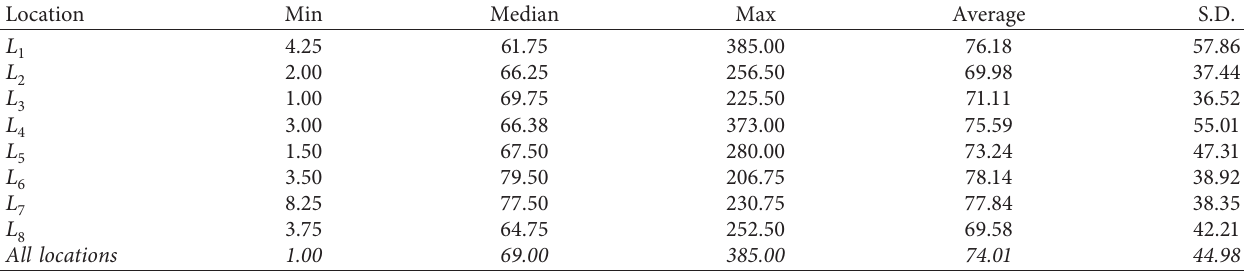
Table 7: The summary statistics of PM10 density of the eight selected locations from 1 st January 2016 to 31 st May 2016.